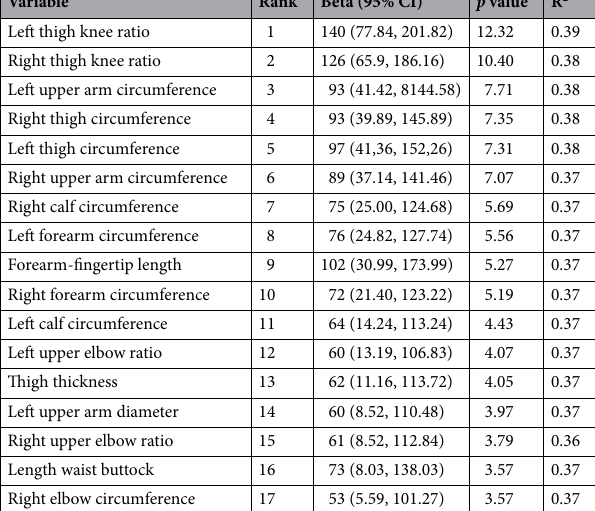
Table 2. Characteristics of the strongest anthropometric markers related to VO2peak for men. Detailed explanation of the parameters see supplementary Table